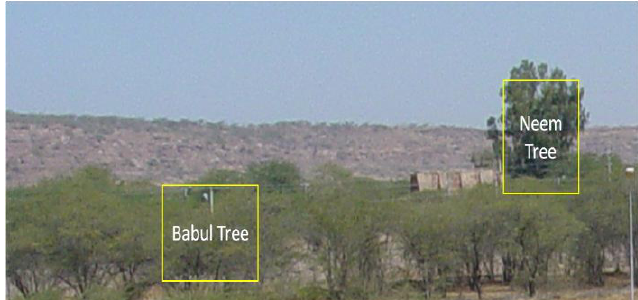
Fig.12. Field Photo of Data Acquition Sites of Babul and Neem Trees